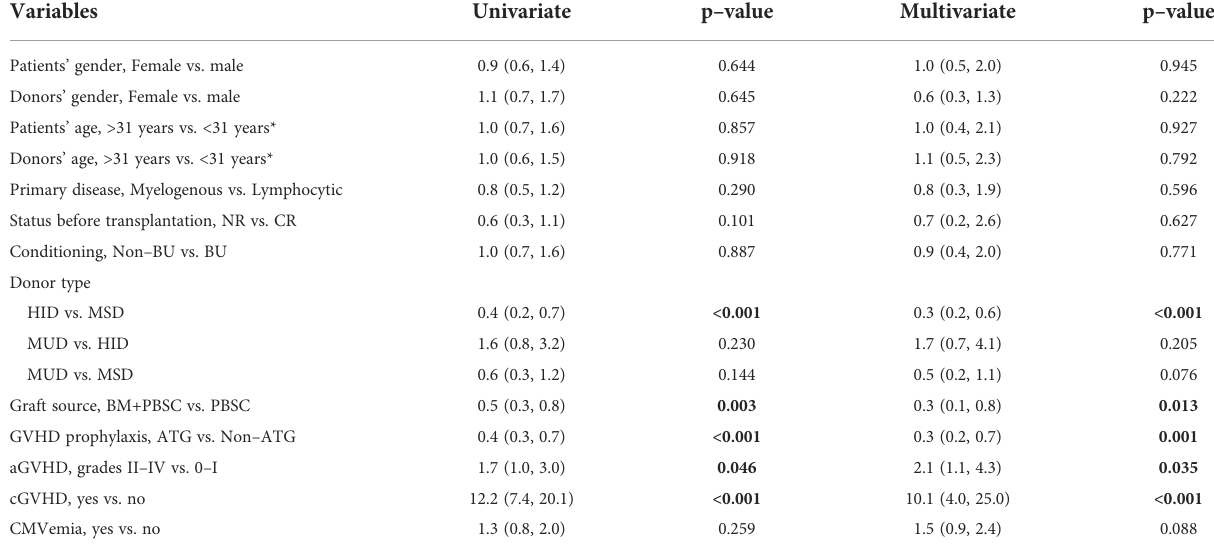
TABLE 3 Risk factors of